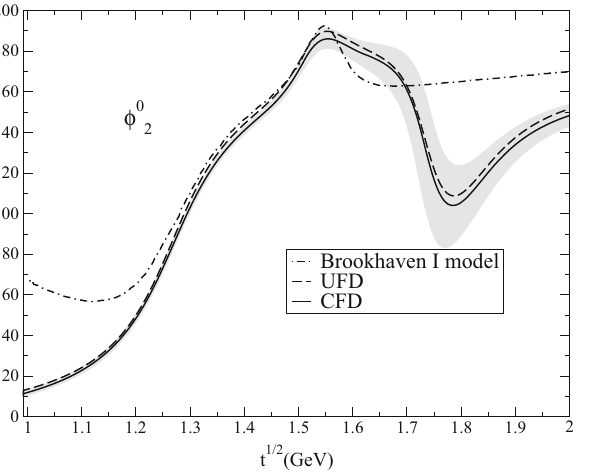
Fig. 13 Comparison between the UFD and CFD g 0 with a model including an f 2 ( 1810 ) resonance and the one obtained with the Brookhaven model without it, using a flat background